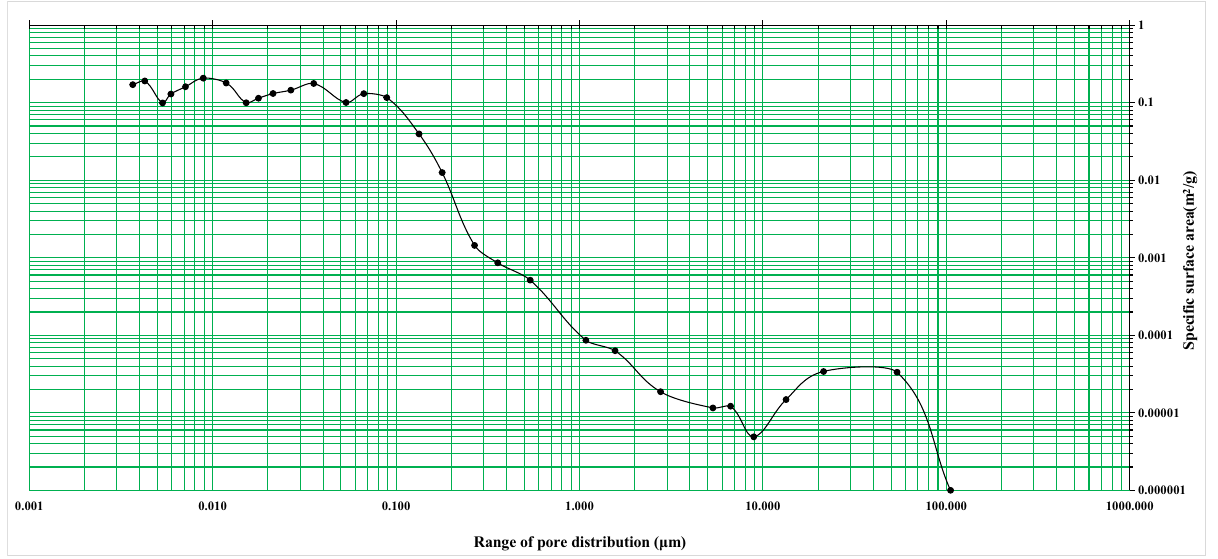
Figure 1: Relation between pore diameter and speci fi c surface